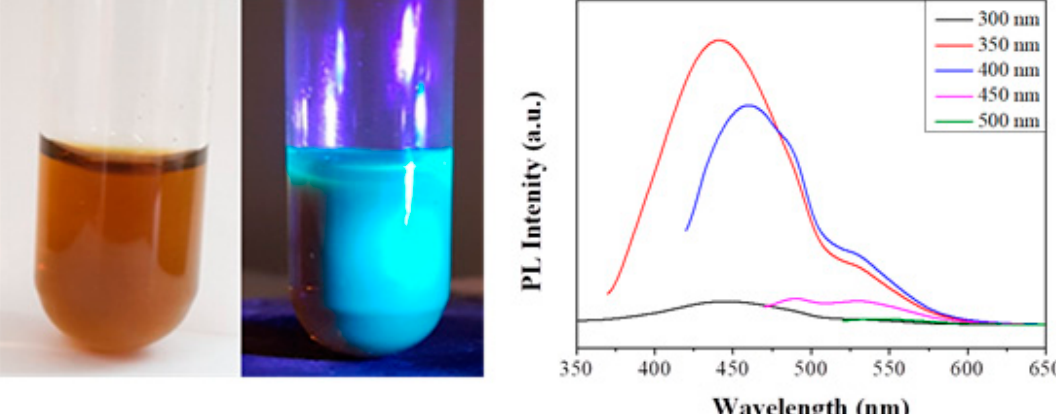
Figure 9. ( Left ) aqueous dispersion of the diglycolamine-modified solid under natural and UV light. ( Right ) the corresponding photoluminescence spectra of the amine-modified carbon at different excitation wavelengths ( λ ex as inset).